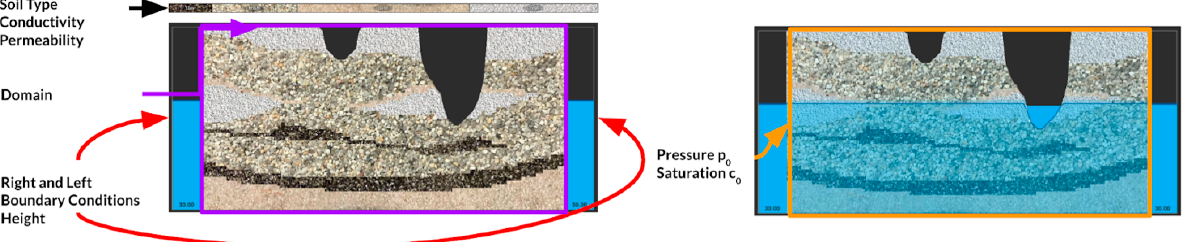
Figure 7. Variable 2D input parameters for the generation of Sandtank-ML emulation training data.